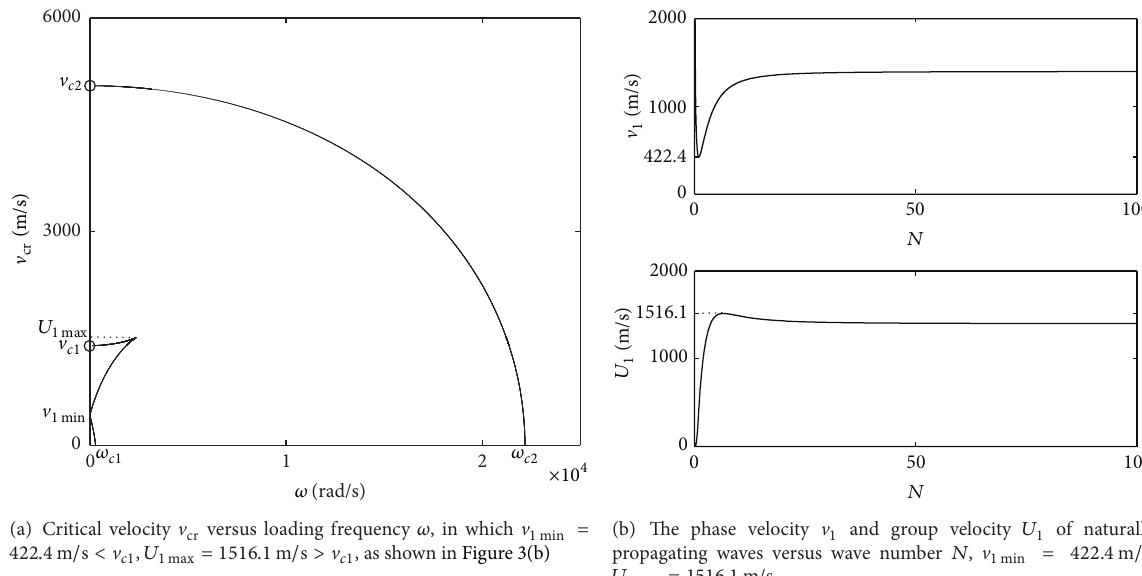
(a) Critical velocity V cr versus loading frequency 𝜔 , in which V 1 min = (b) The phase velocity V 1 and group velocity 𝑈 1 of naturally 422.4 m / s < V 𝑐1 , 𝑈 1 max = 1516.1 m / s > V 𝑐1 , as shown in Figure 3(b) propagating waves versus wave number 𝑁 , V 1 min = 422.4 m / s, 𝑈 1 max = 1516.1 m/s Figure 3: Critical velocity V varies with loading frequency 𝜔 for 𝑘 = 5 × 10 6 N/m 2 . cr